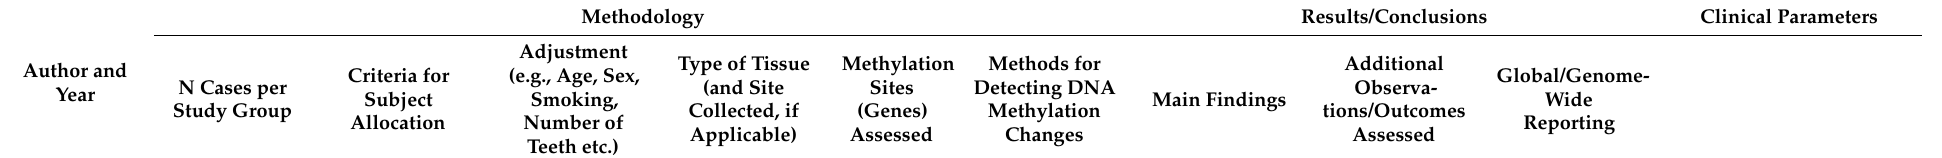
Table 2. Description of epigenetic testing and